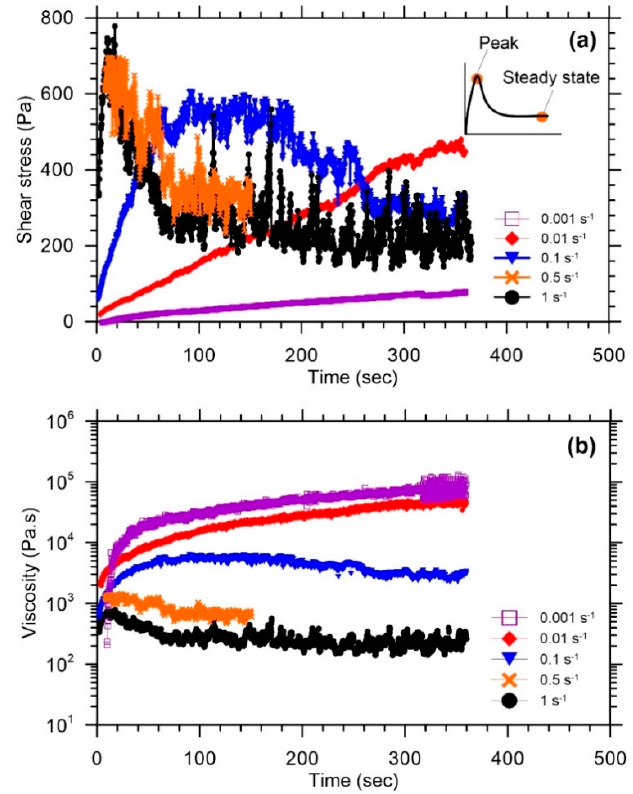
Figure 4. Stress growth test: ( a ) Shear stress–shearing time; ( b ) viscosity–shearing time.